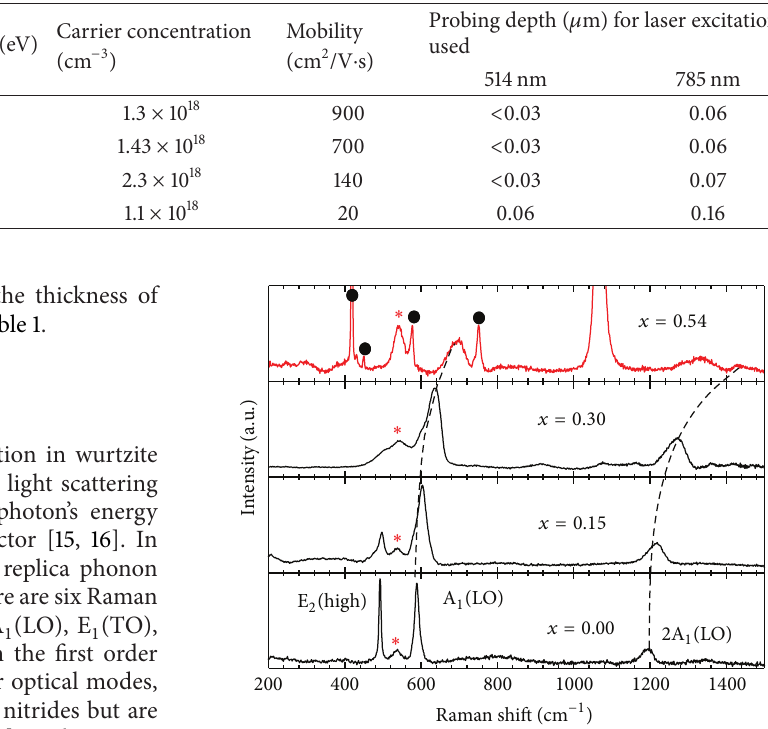
Table 1: Room temperature electronic and optical properties of In 1−𝑥 Ga 𝑥 N thin films.